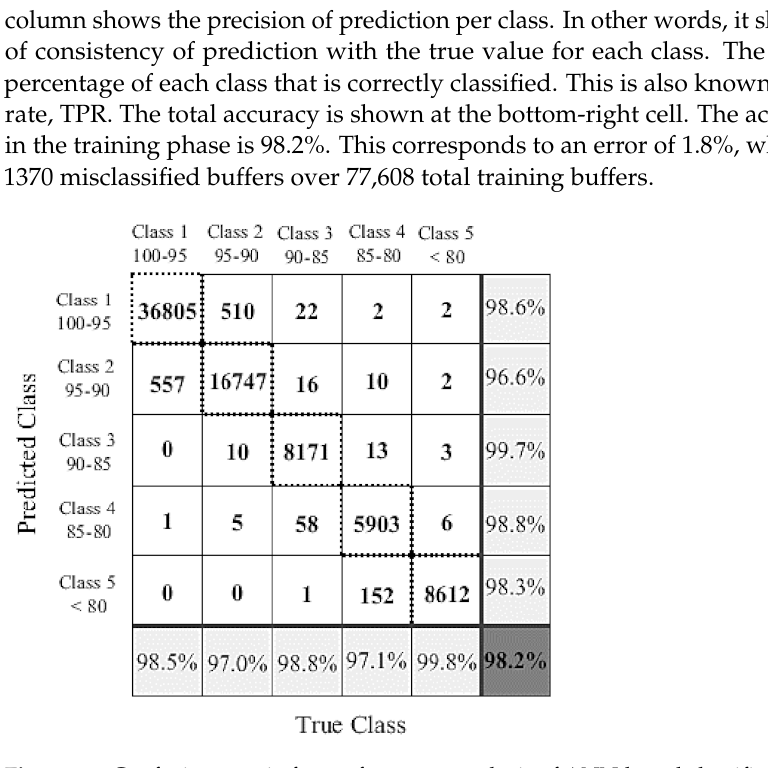
Figure 12. Confusion matrix for performance analysis of ANN-based classifier in the dataset trained with LG 18650 MJ1 lithium-ion. The diagonal cells are correctly classified buffers. The last row with gray background is the TPR. The last column with gray background is the precision per class. The bottom right cell with dark background is the total